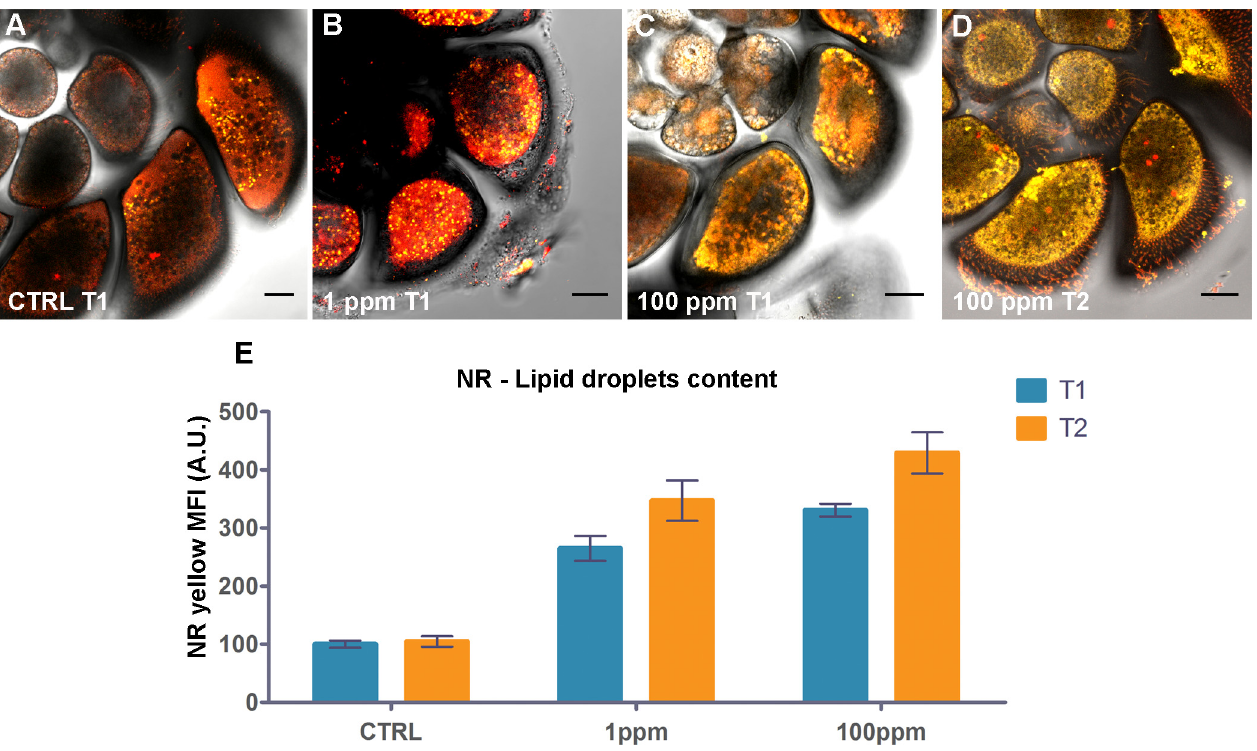
Fig 1. Effect of Hg exposure on lipid distribution of A . parkinsoniana labeled with NR. Epifluoresecence micrographs of single optical sections showing overlay of NR yellow and red fluorescence for (A) T1- control, (B) T1-1 ppm, (C) T1-100 ppm and (D) T2-100 ppm, Bars: 20 μ m. (E) Histogram of yellow Mean Fluorescence Intensity (MFI) expressed in arbitrary units (A.U.) for the three treatments over time (control, 1 ppm, and 100 ppm at both T1 and T2). Error bars indicate ± standard error of the mean.